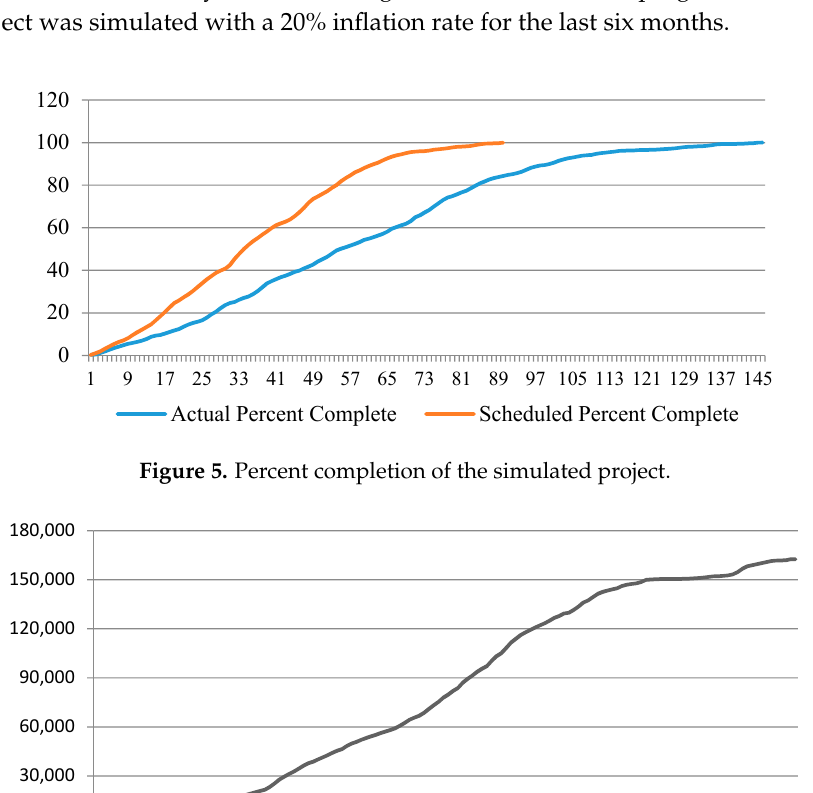
Figure 5. Percent completion of the simulated project.